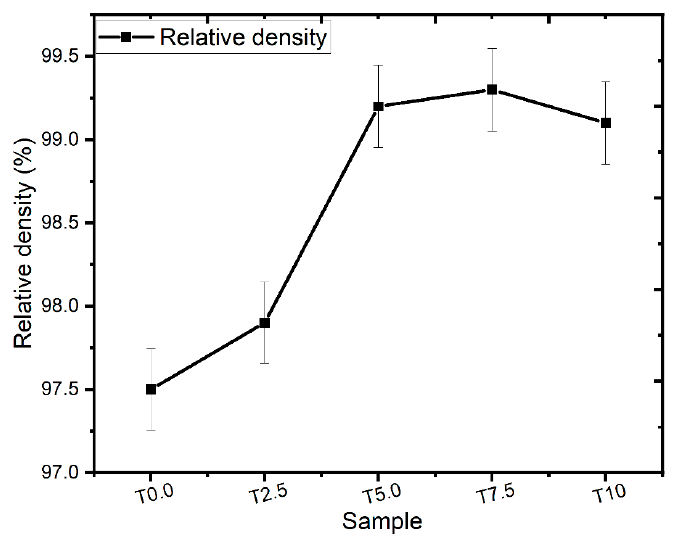
Figure 2. The relative densities of the consolidated Ti and TiB 2 – Ti composites.